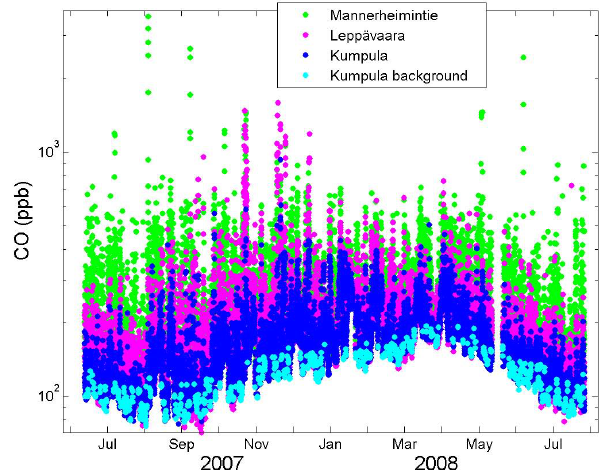
Fig. 2. Hydrogen mixing ratios at Kumpula site in Helsinki. All refers to all hourly mean values and background to selected hourly values. Red line is the harmonic fit to the background data.